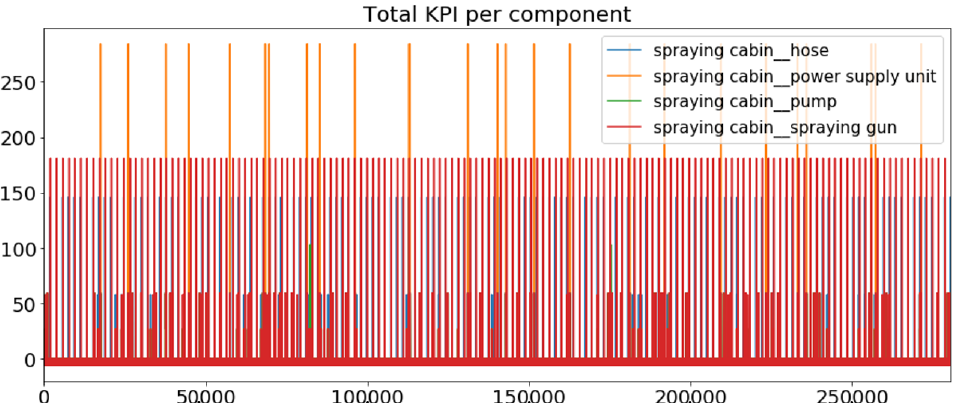
Figure 2. Total KPI time series yielded from running the model for the spraying cabin (GORENJE). The simulation interval has a length of 8 years.